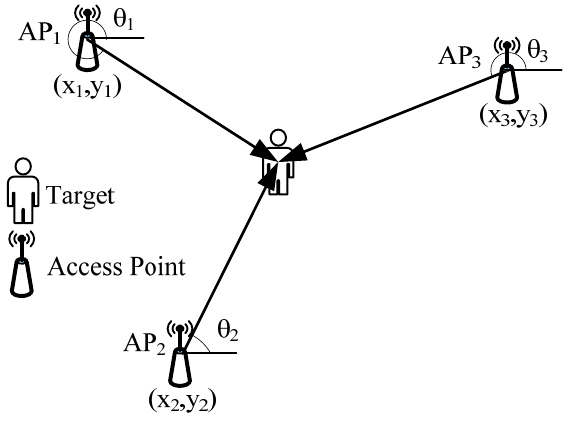
Figure 6. AOA-based Figure 6. AOA ‐ based triangulation.